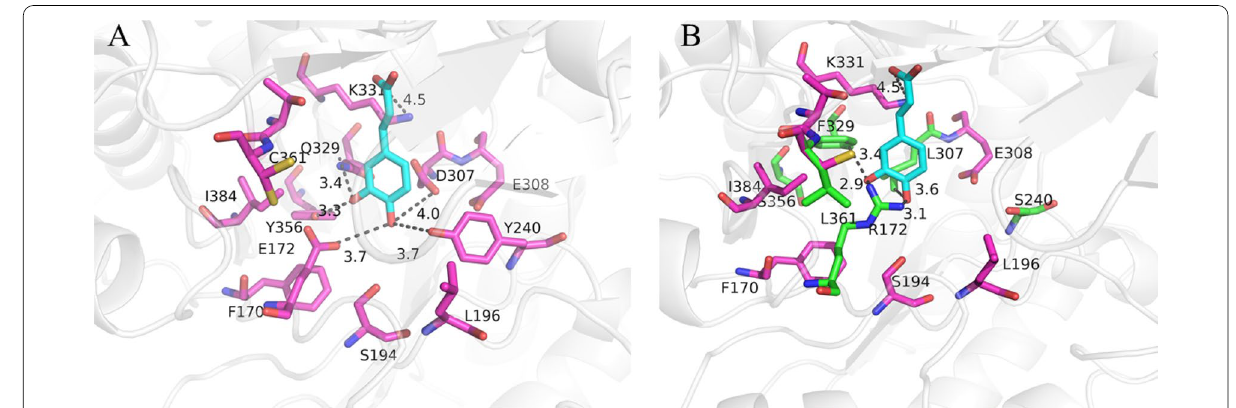
Fig. 4 Comparison of hydrogen bonding in Ec MAL WT ( A ) and its variant Ec MAL M8 ( B ). The docking substrate ( 1a ) and amino acid residues are shown in sticks. The hydrogen bonds are shown in black imaginary